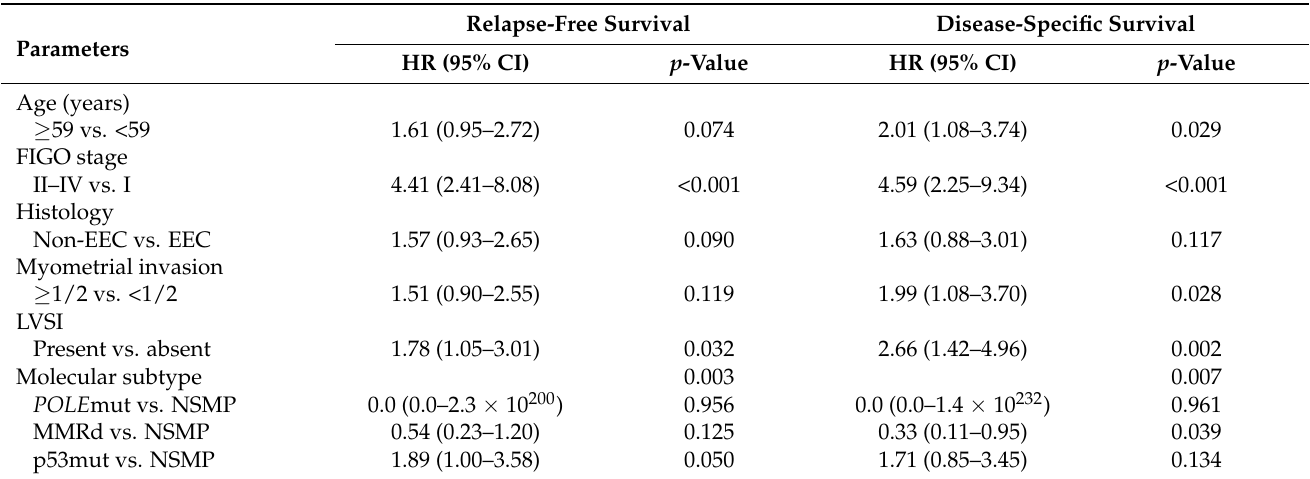
Table 2. Univariate analysis of factors potentially predictive of survival in patients with high-grade endometrial